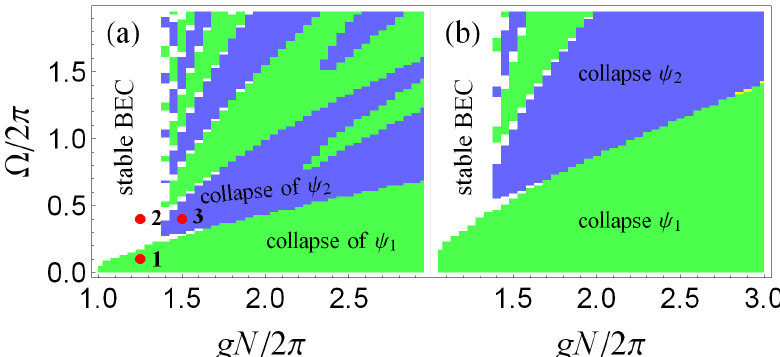
Figure 1. The diagram of stable and collapsing condensate is plotted in ( gN , Ω ) − plane for intra-spin interaction κ = − 1 given in Equation (1). The left panel ( a ) and the right panel ( b ) are plotted for √ initial width of condensate a 0 = 1 and a 0 = 1/ 2, correspondingly. Below in the next figures we will present characteristic dynamics of the condensate for the values of ( gN , Ω ) from the fixed points (1,2,3) in the panel ( a